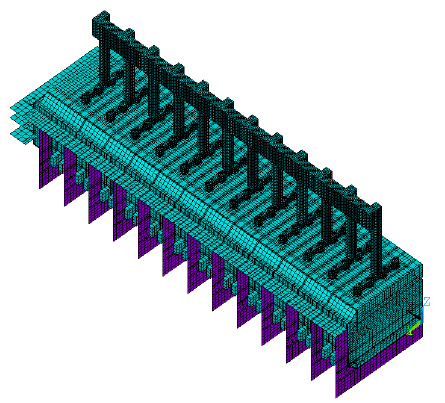
Figure 1. 3D thermo-electric field quarter model built by ANSYS.